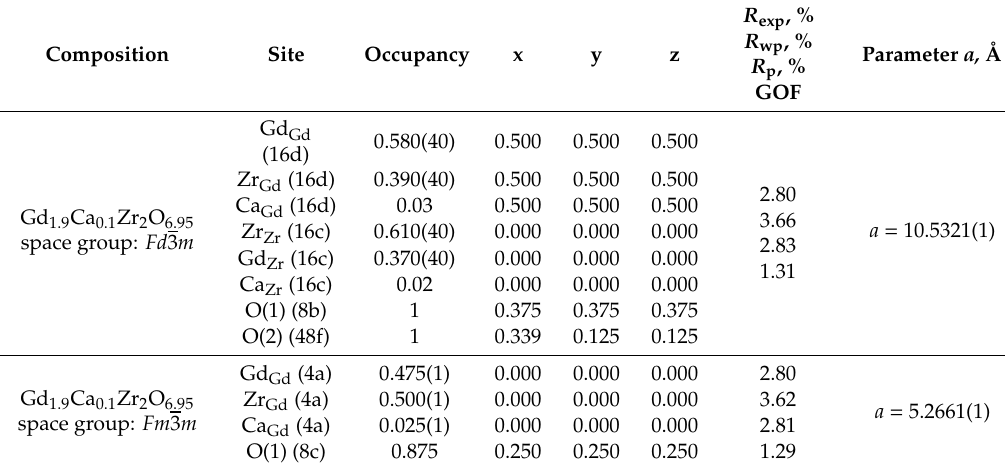
Comparison of the nominal cations stoichiometry and SEM / EDX point analysis of